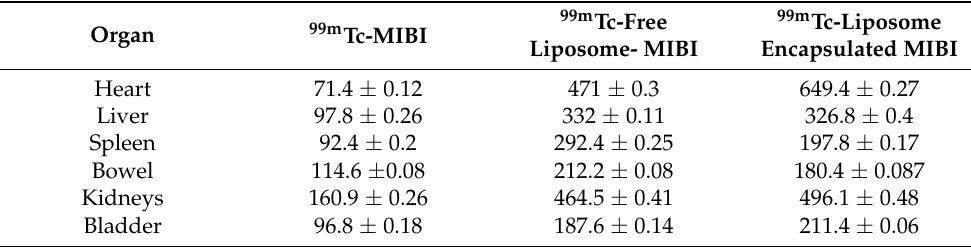
Table 1. Blood-pool biodistribution of 99m Tc-MIBI compared to that of 99m Tc-liposomal agents in different organs.